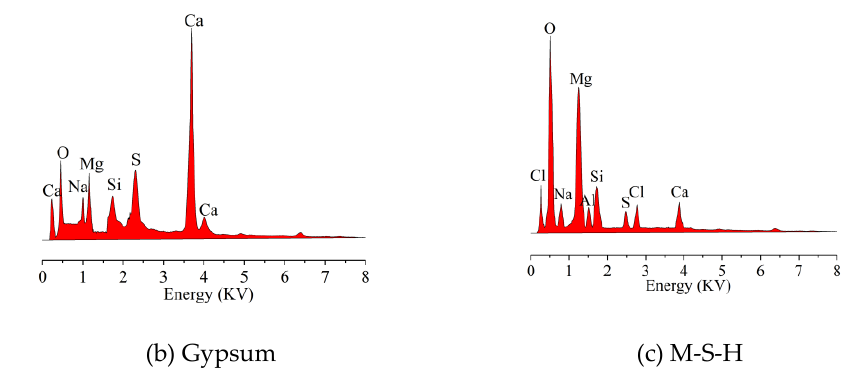
Figure 19. Microscopic morphology of MK concrete eroded by MgCl 2 solution.